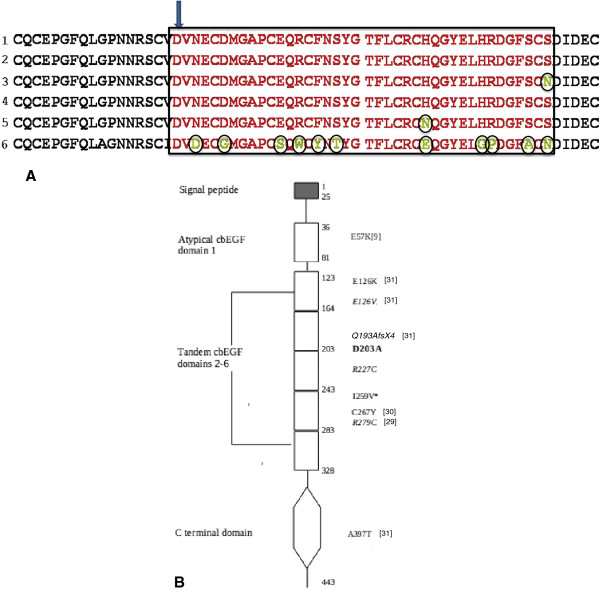
Sequence alignment of fibulin-4 and location of mutations.A:
Multiple sequence alignment of fibulin-4 protein sequence from (1) Homo
sapiens, (2) Pan troglodytes*, (3) Canis lupus
familiaris*, (4) Bos taurus, (5) Mus musculus,
(6) Danio rerio ; sequences from species marked * were computationally
predicted. cbEGF4 sequence is enclosed in the rectangular box.
Substitutions within the domain are encircled. Arrow marks the position of
aspartate 203 in human fibulin-4. Conservation of amino acid identity of
this aspartate across species and its sequence position at start of the
cbEGF4 domain, indicates its functional significance. All patients had
identical missense mutation at this crucial position. B : Schematic
representation of domains, based on Swiss-Prot annotation
[Swiss-Prot:O95967]. The types of domain are listed on the left. Amino acid
position in fibulin 4 sequence is noted at start and end positions of the
protein, the atypical cbEGF domain and the region containing 5 tandem cbEGF
domains. Mutations listed on the right are found in human disease with the
exception of I259V*. The D203A mutation (bold) is the one found in all
patients in our cohort. Mutations shown in italics occurred in compound
heterozygotes. References are shown in brackets.